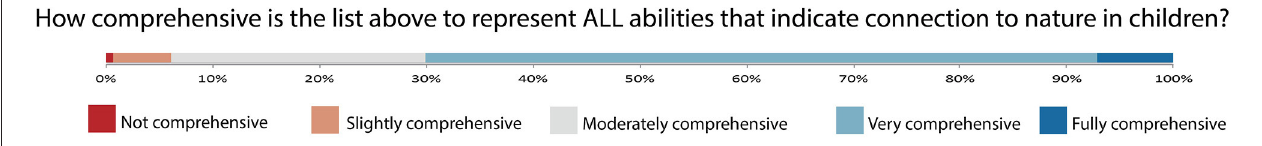
FIGURE 3 | Results from the questions on abilities of HNC in the survey. Top: how much professionals agreed that the list of abilities of human-nature connection indicated children’s HNC. Bottom: professionals’ responses on how comprehensive the list of was to represent all abilities that indicate children’s HNC.